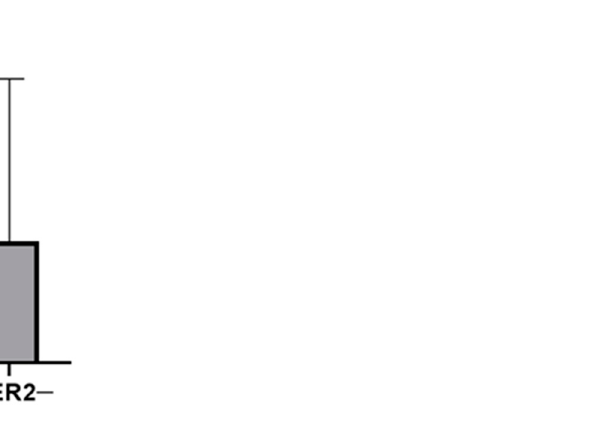
Figure 4. Comparison by Mann–Whitney test of the IC 50 values of the HER2+ and HER2 − groups ( p = 0.4).